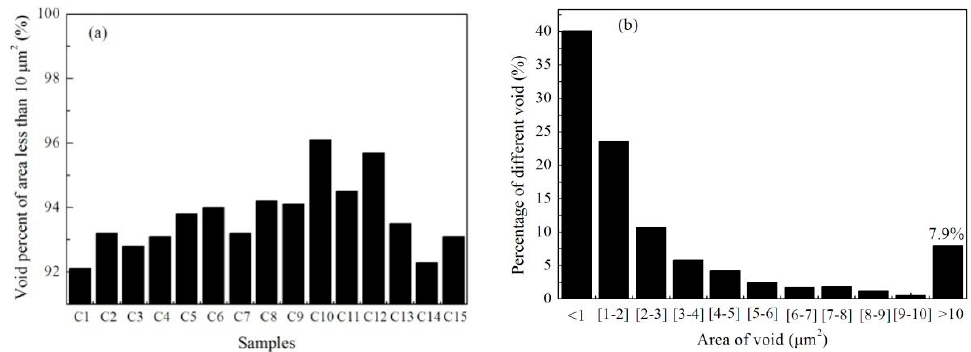
Figure 3. Analysis of voids in fifteen kinds of deposited coatings: ( a ) The percentage of voids with less than 10 μ m 2 of area; ( b ) The percentage of different voids in C1 coatings.